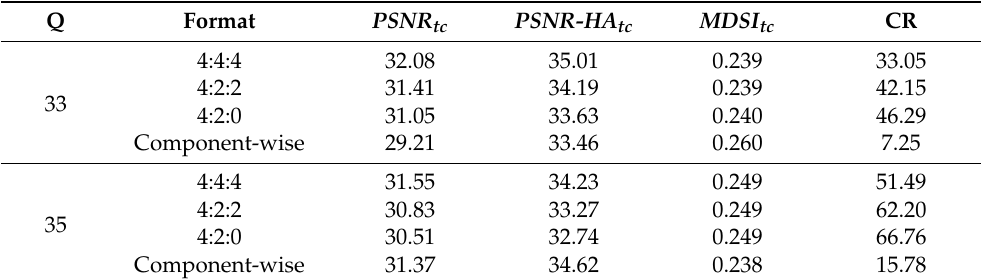
Table 3. Data for comparison of compression variants’ performance characteristics.